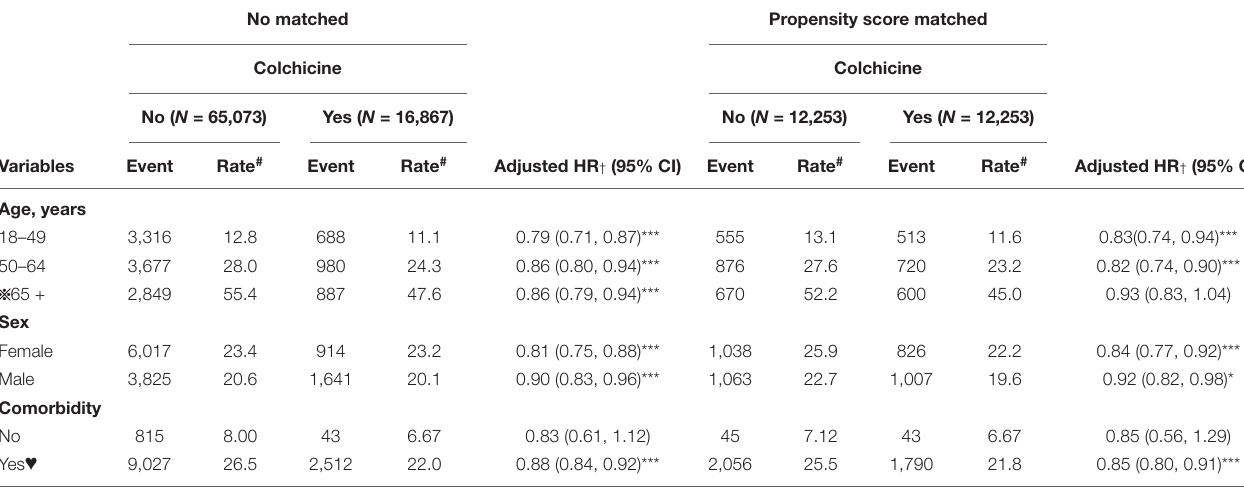
TABLE 1 | Incidence and hazards ratio (HR) of heart disease (HD) measured by age, sex, and comorbidity in colchicine users compared with those in colchicine non-users by Cox proportional hazard models with time-dependent exposure covariates. No matched Propensity score matched Colchicine